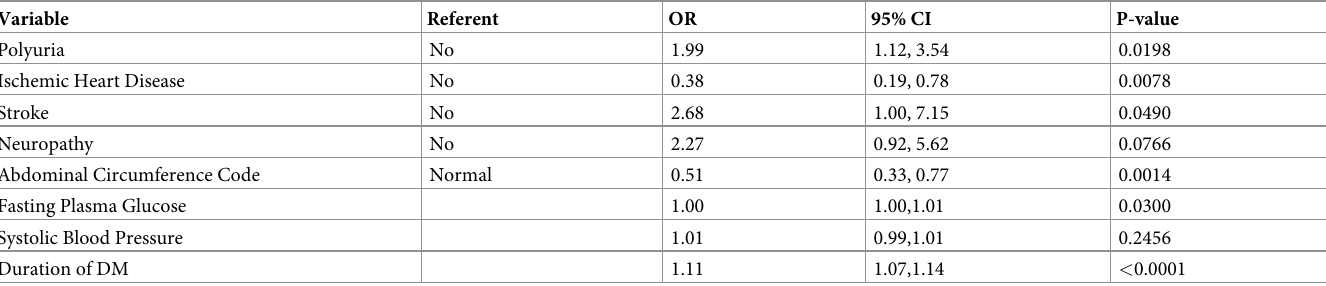
Table 8. Hypertension only–Stepwise multivariate